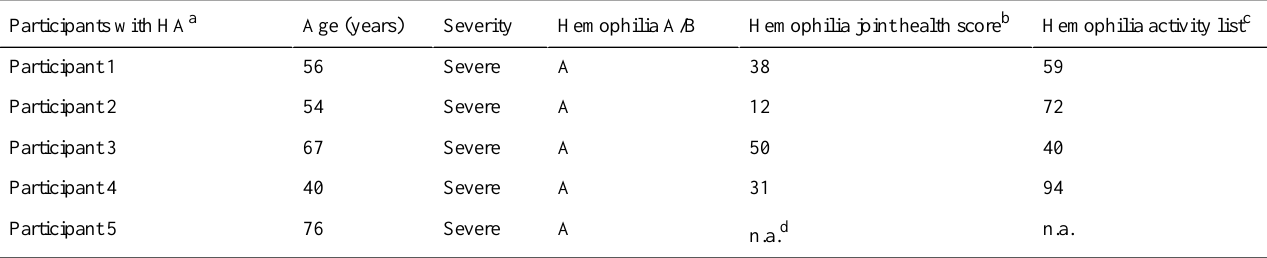
Table 1. Focus Group 1: Demographic characteristics of the participating patients.